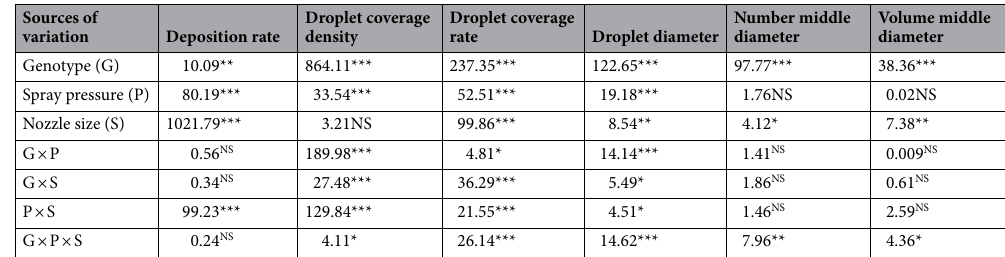
Table 1. Results of ANOVA in the rice deposition and distribution of droplets. NS not significant. *Denotes significance at the P ≤ 0.05 level. **Denotes significance at the P ≤ 0.01 level. ***Denotes significance at the P ≤ 0.001 level.